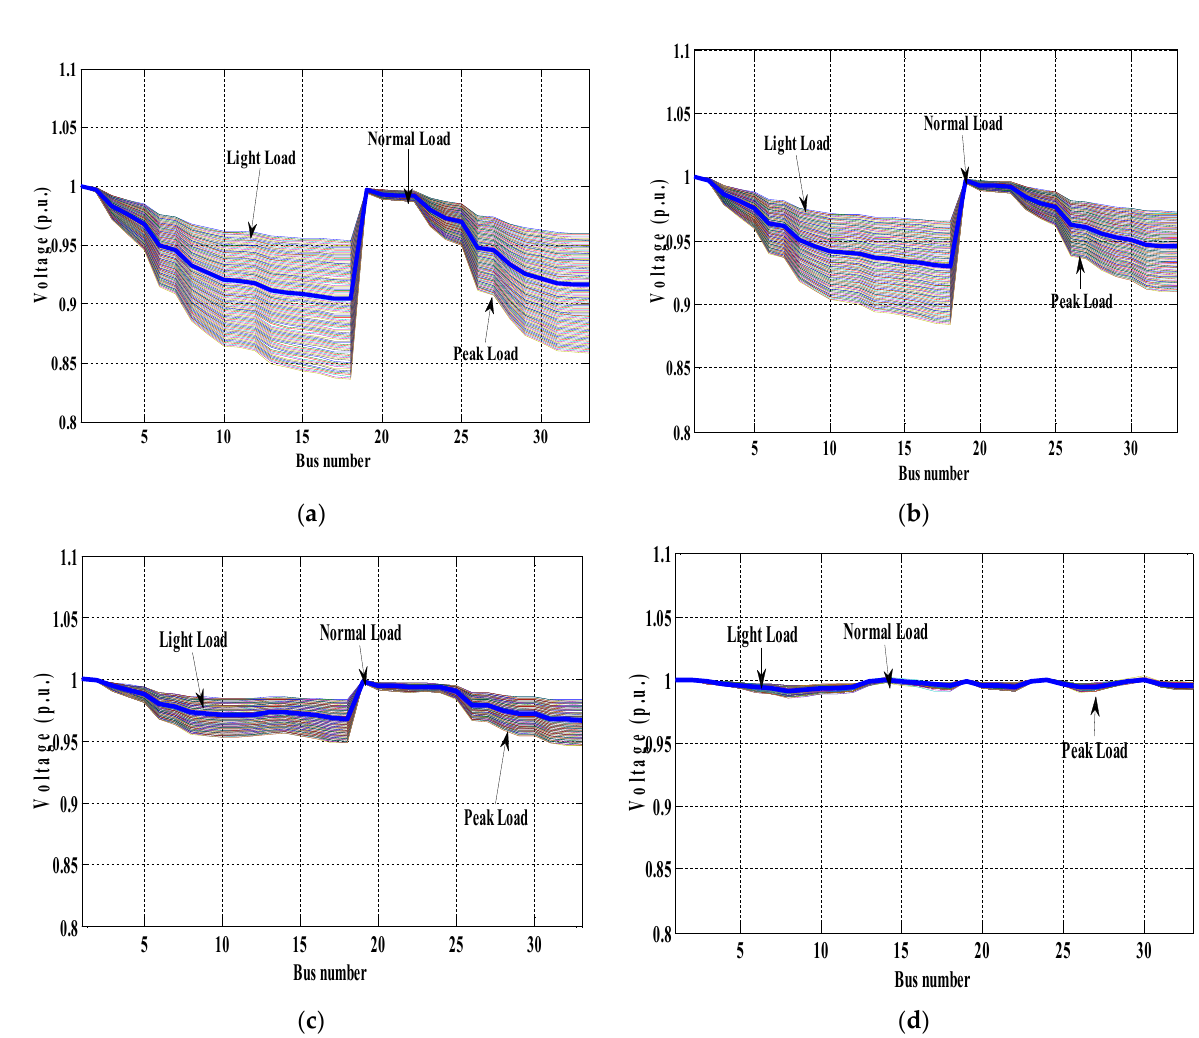
Figure 4. ( a ) IEEE 33-test system voltage profile (Scenario-I). ( b ) IEEE 33-test system voltage profile (Scenario-II). ( c ). IEEE 33-test system voltage profile (Scenario-III). ( d ) IEEE 33-test system voltage profile (Scenario-IV).